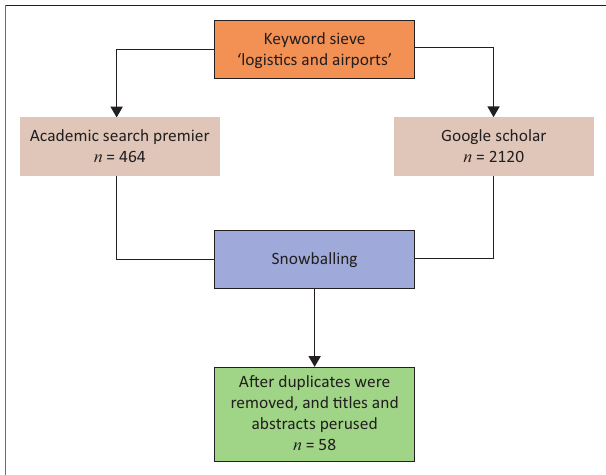
FIGURE 1: Literature search